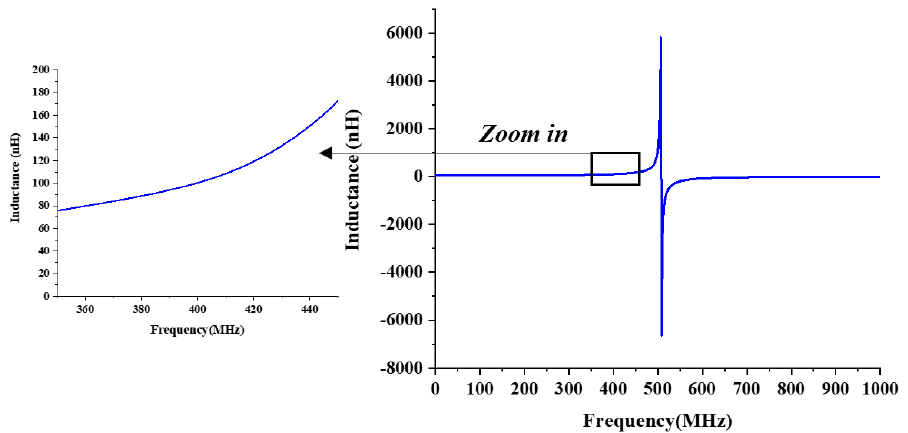
Figure 7. Simulated inductance of the optimised four-turn split-ring loop.